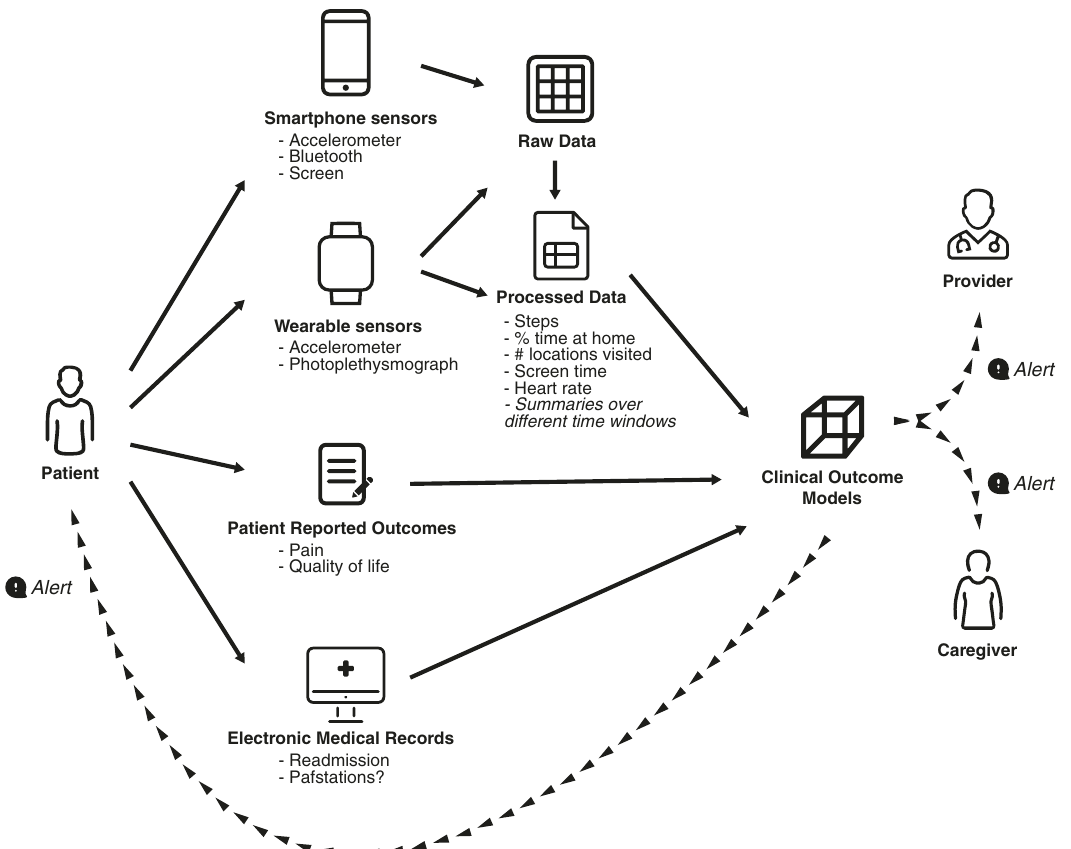
Fig. 1 Highlights a mobile sensing framework for monitoring oncology patients. Patients provide passive sensor data via smartphone and wearable sensors that, when combined with patient-reported outcomes or electronic health record data, can be used to generate clinical risk prediction models. These models can be used to trigger alerts for oncology providers or alerts for personalized interventions for patients and